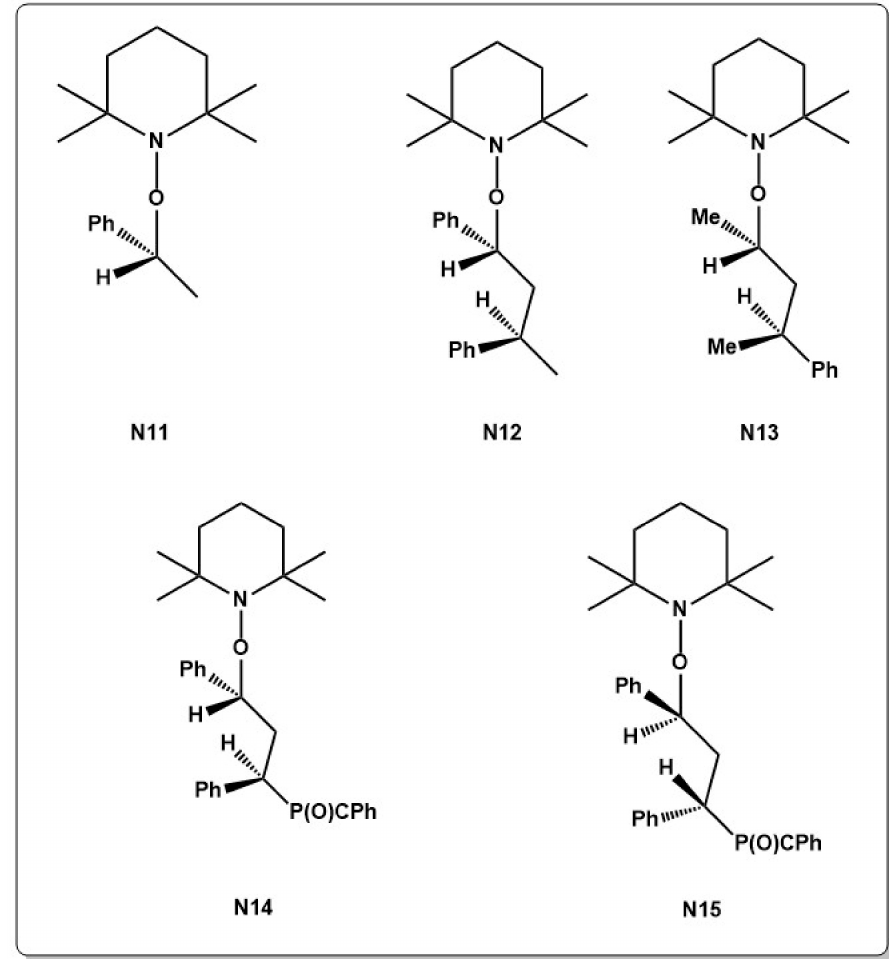
Chart 3. Alkoxyamines bearing stereo centers used in